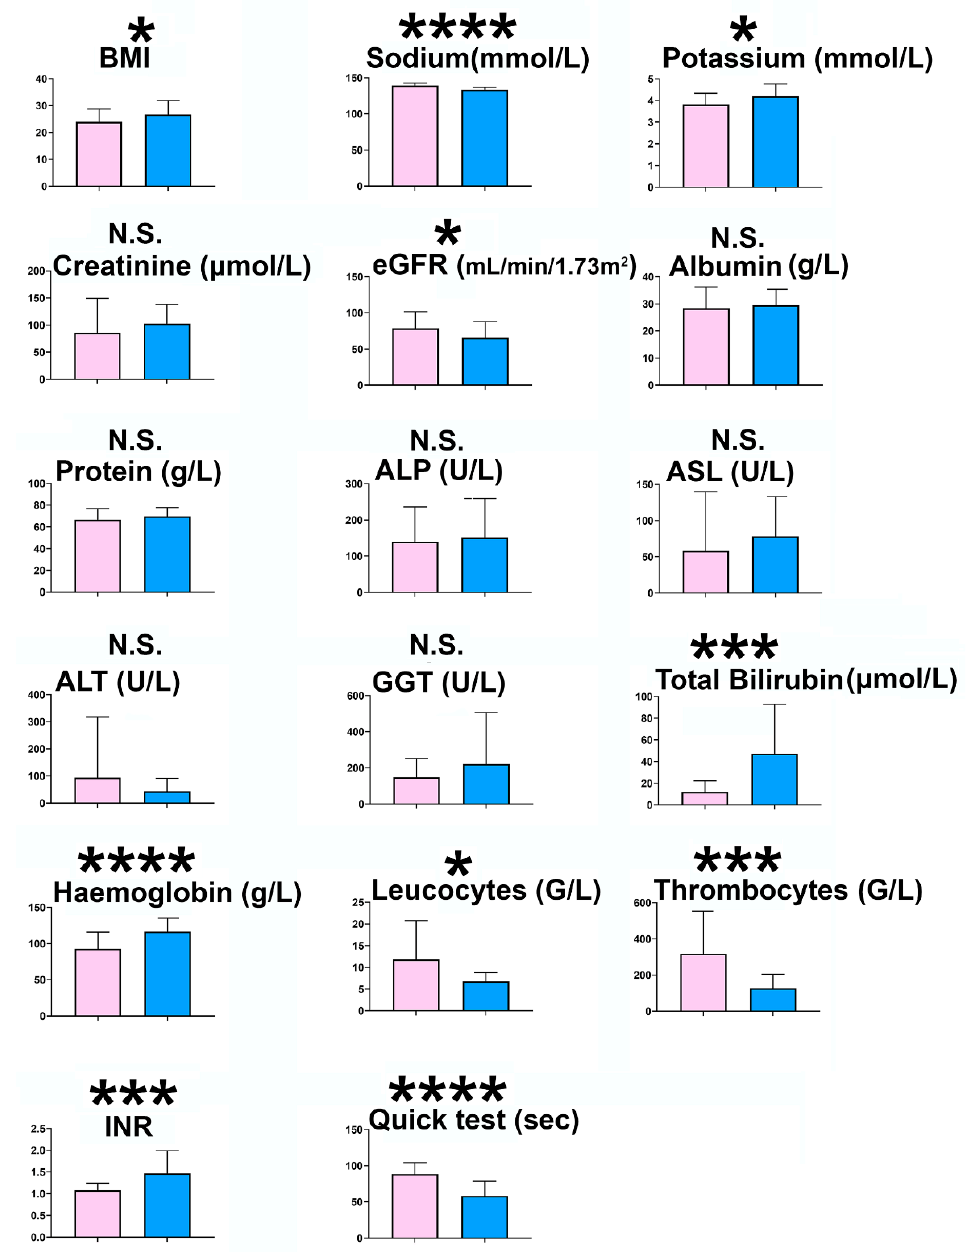
Figure 3. Clinical variables for 33 cirrhotic ascites patients (blue) and 33 surgical postoperative drainage patients (pink) shown as means ± SD. Statistical significances are represented by *, p < 0.05; ***, p < 0.001; ****, p < 0.0001.